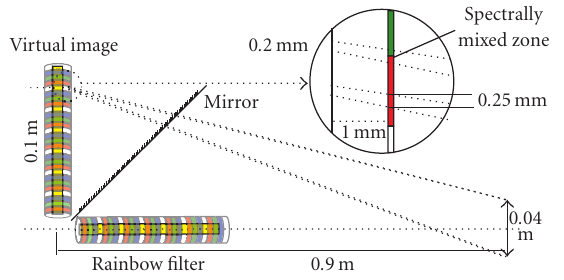
Figure 2: Zoomed view of light transmitting through the rainbow mouse